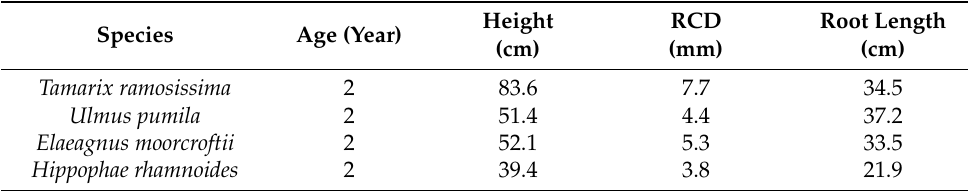
Table 1. The initial age and growth of the tree species used in the experiment.